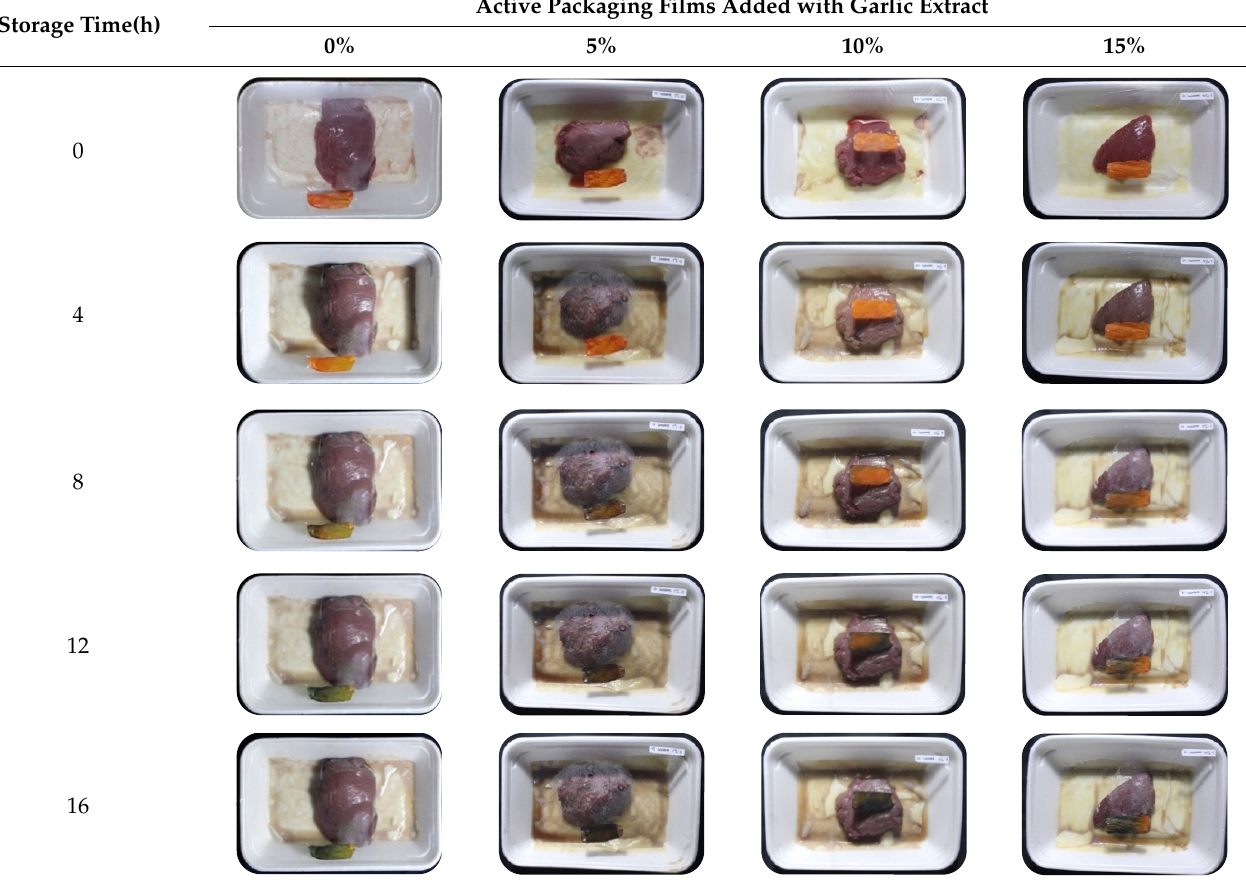
Table 4. Changes in the color of the intelligent packaging indicator (BTB solution, pH 2.75) when used together with the active packaging films to reflect the freshness of meat.